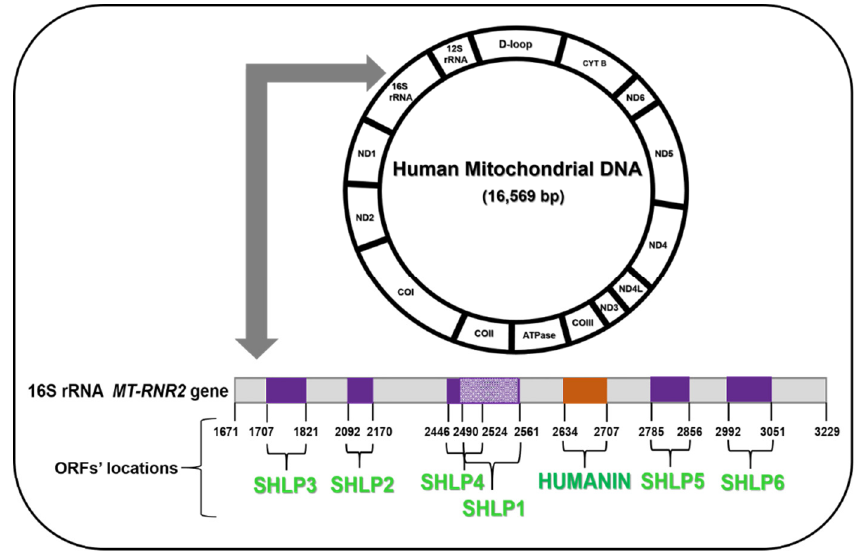
Figure 1. Humanin and Small Human-Like Peptides (SHLPs) Open Reading Frames (ORFs) in the human mitochondrial DNA.